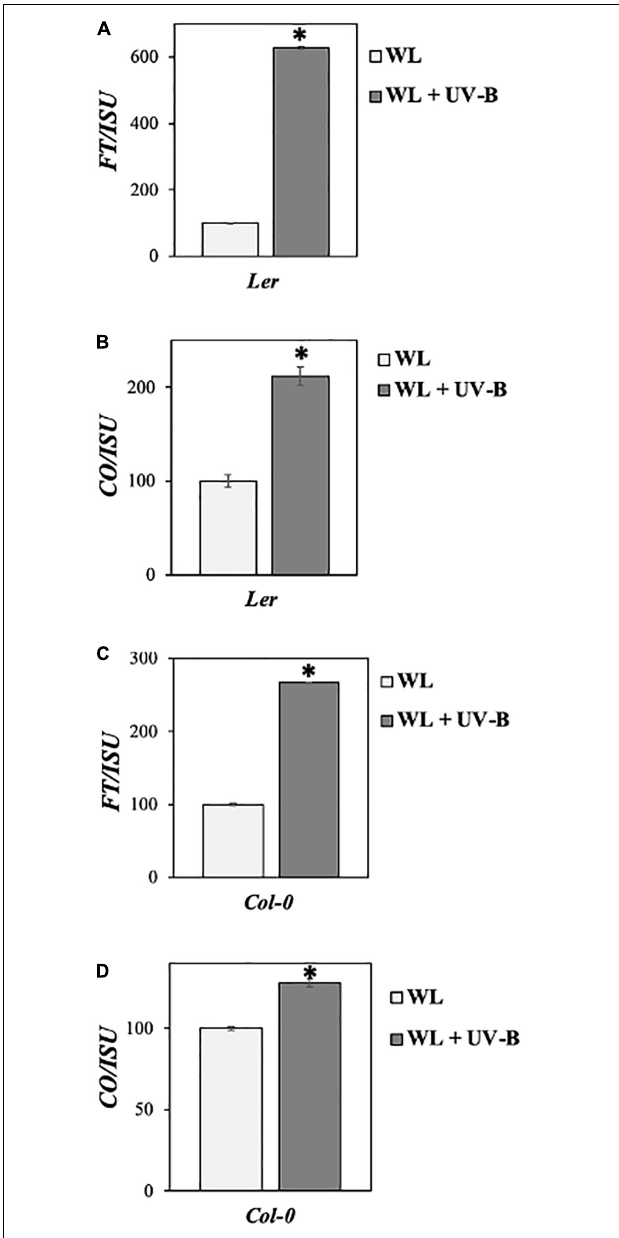
FIGURE 2 | UV-B induces photoperiodic pathway genes FT and CO in Col-0 and Ler ecotypes. (A–D) qRT-PCR analysis of FT and CO transcript levels in Ler (A,B) and Col-0 (C,D) normalized with the housekeeping gene ISU. Plant tissue was collected at ZT 0.5 12 days after germination. Plants were grown under a LD photoperiod of WL (50 µ mol m − 2 s − 1 ) or WL supplemented with UV-B (0.5 µ mol m − 2 s − 1 ). Plants grown under WL were used as reference (100%). Data are represented as mean ± SEM. Data are representative of three biological repeats including all genotypes represented above. For each biological repeat three technical qPCR replicates were conducted. ∗ indicates a statistically significant difference.